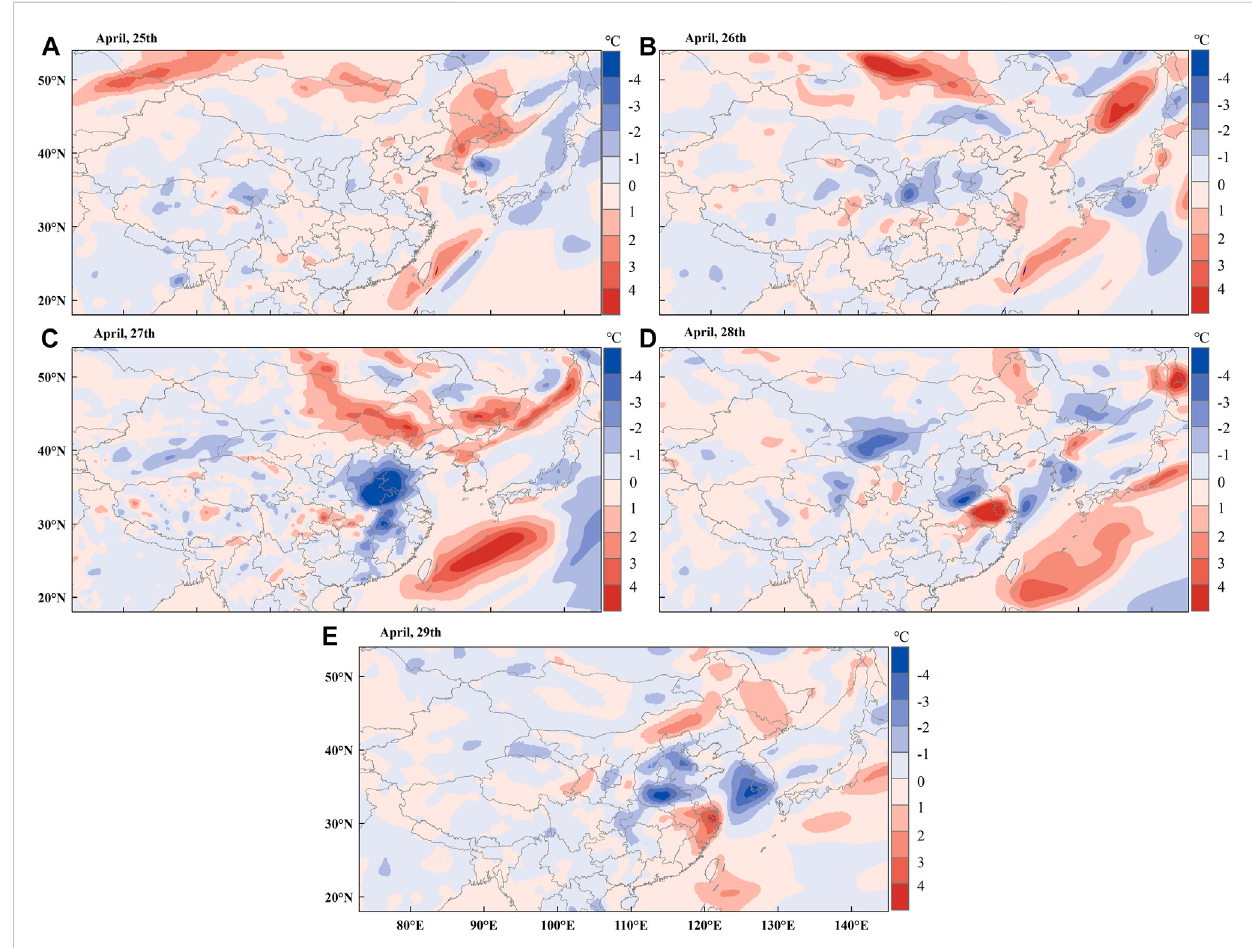
FIGURE 12 Spatial distributions of TR SUR in eastern Asia during April 25 – 29, 2015 [ (A) April 25th; (B) April 26th; (C) April 27th; (D) April 28th; and (E) April